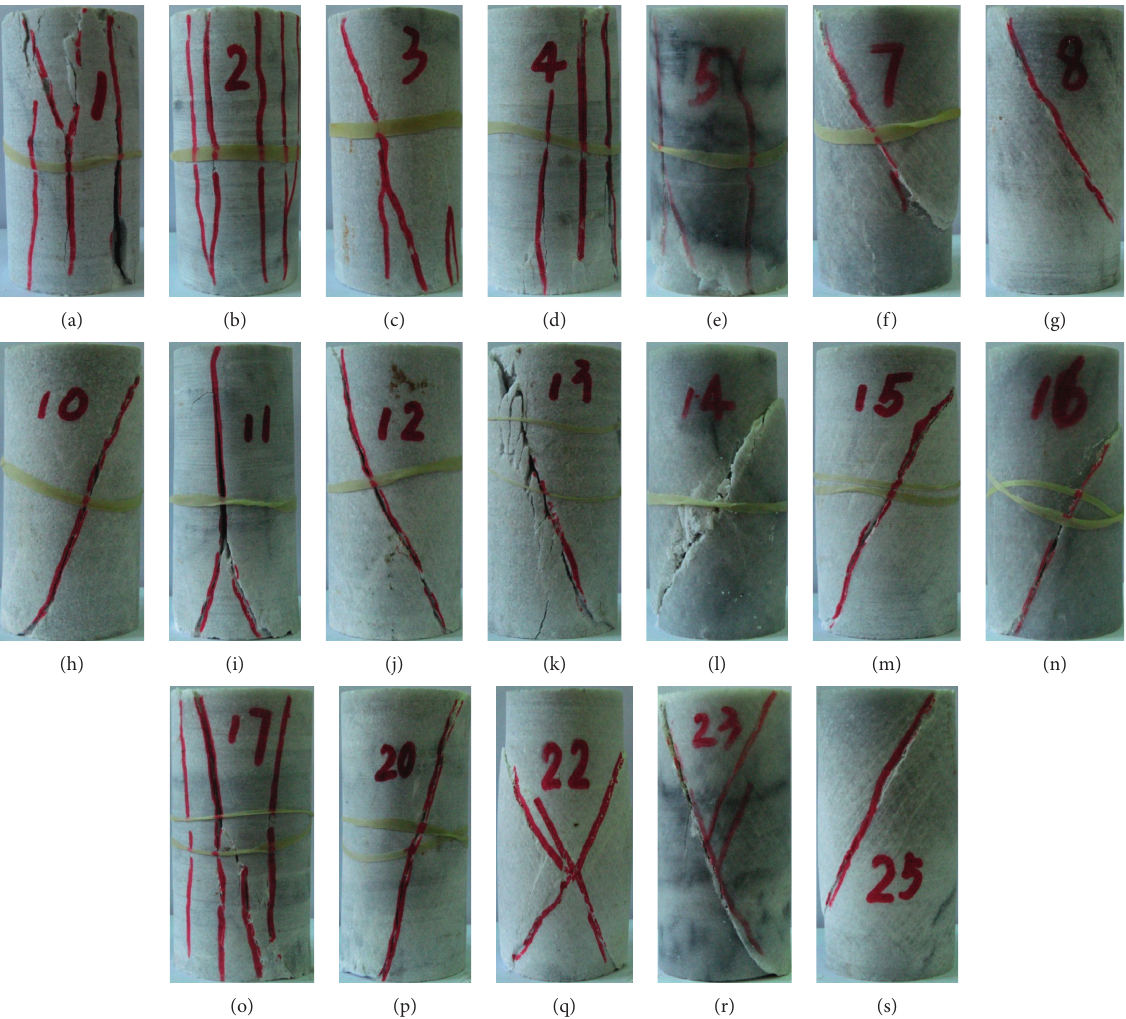
Figure 11: Failure modes of marble specimens: (a) #1; (b) #2; (c) #3; (d) #4; (e) #5; (f) #7; (g) #8; (h) #10; (i) #11; (j) #12; (k) #13; (l) #14; (m) #15; (n) #16; (o) #17; (p) #20; (q) #22; (r) #23; and (s)